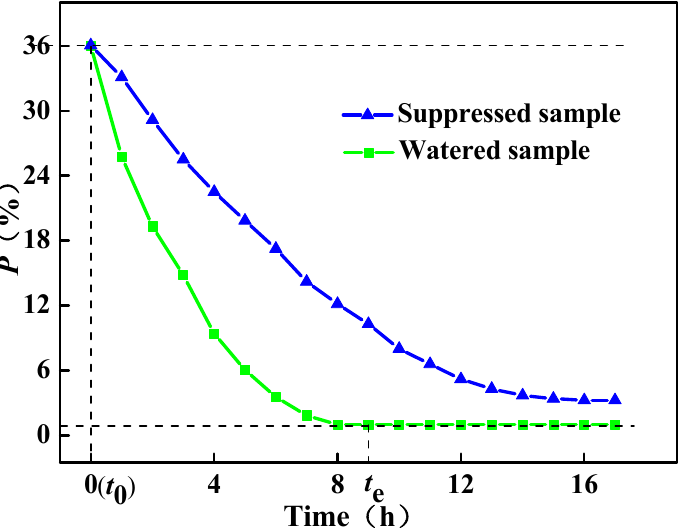
Figure 3. The changes in the moisture content at 35 °C and 45% RH for watered and suppressed samples.